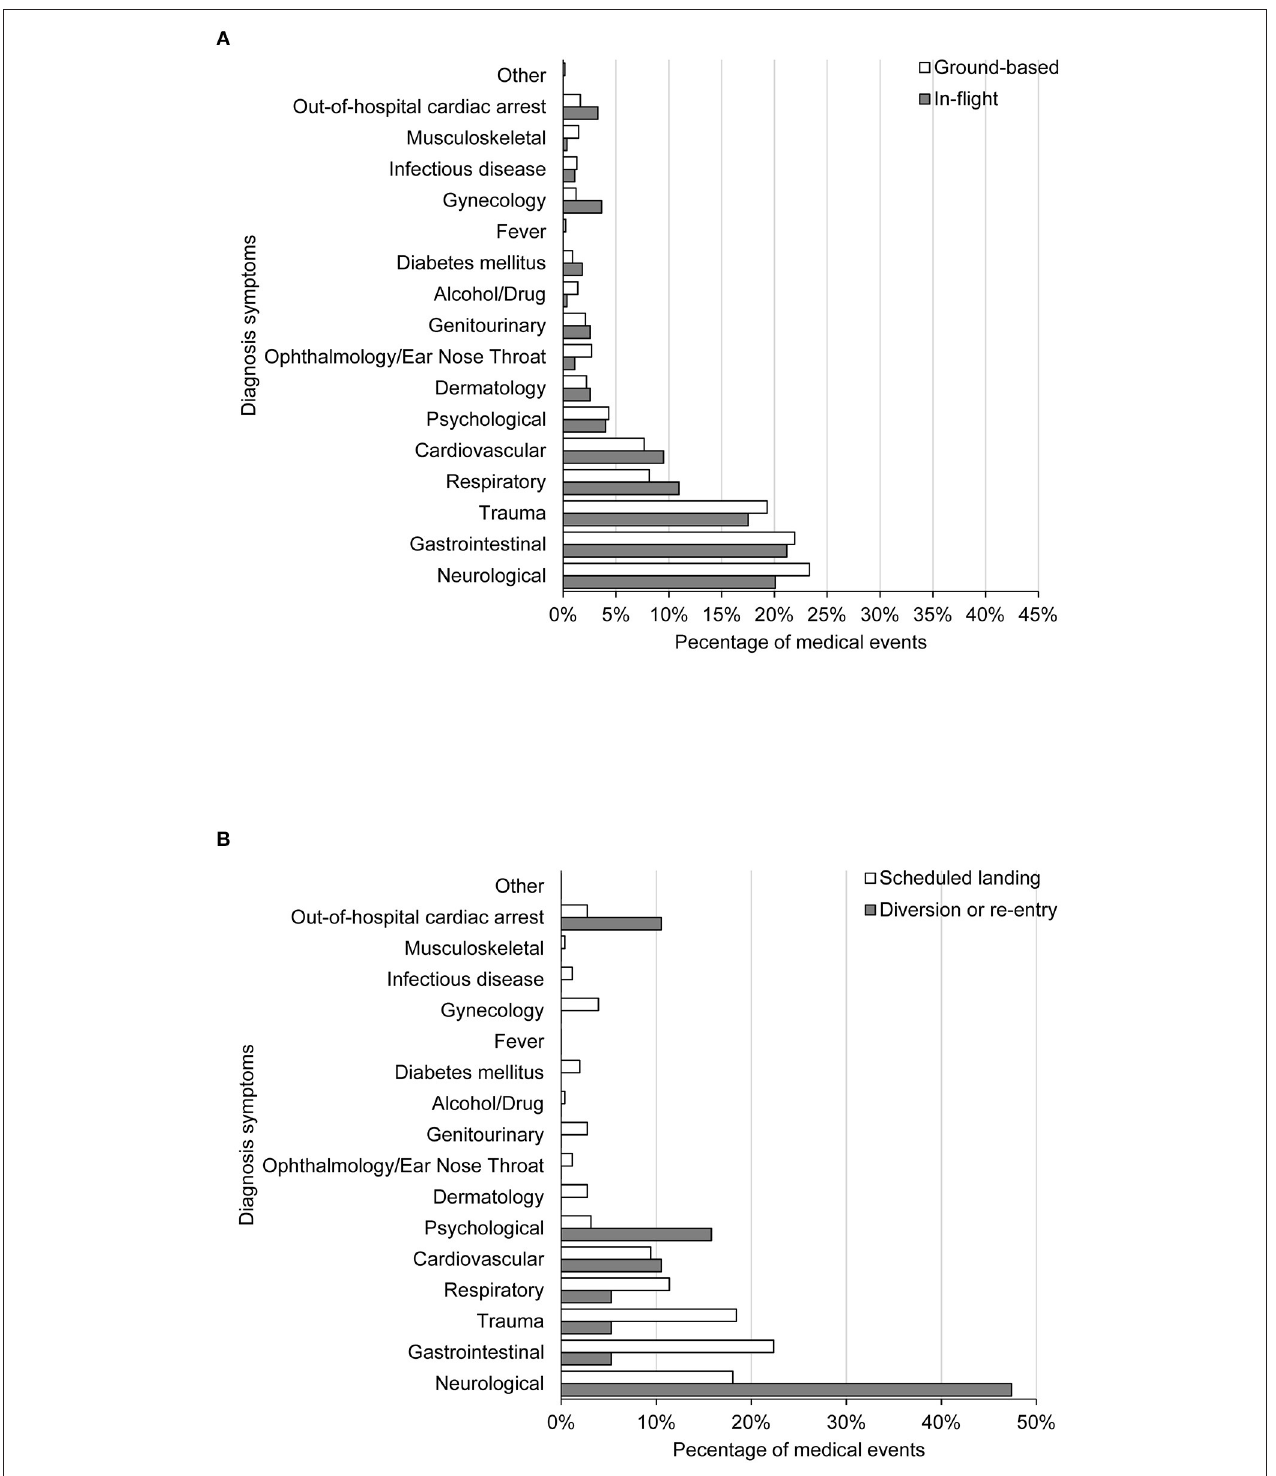
FIGURE 2 | Disease symptoms by diagnosis between in-flight and ground-based medical events (A) and between in-flight medical events with diversion or re-entry and scheduled landing (B) .